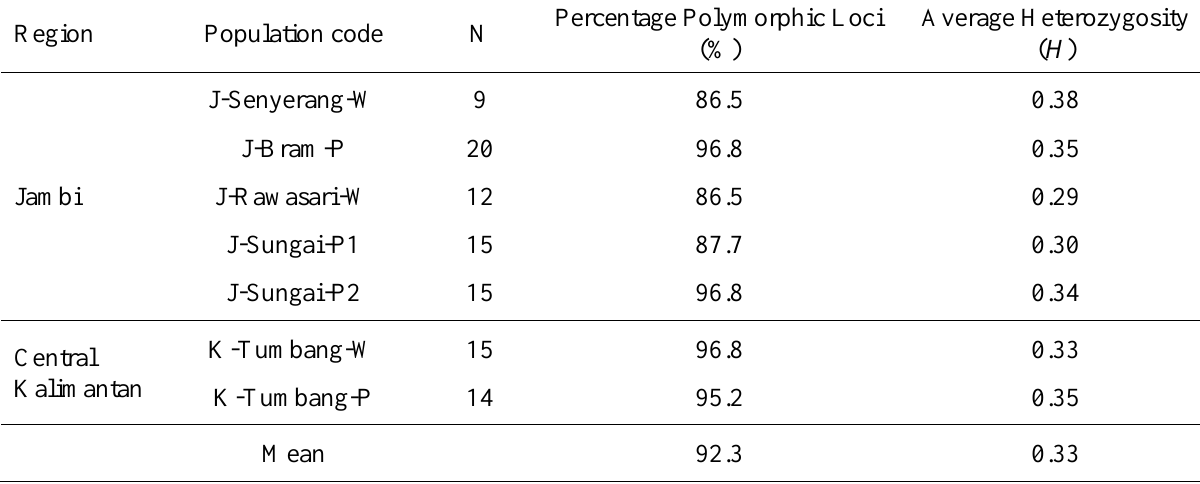
Table 2. Mean diversity estimate ( H ) of 7 Dyera polyphylla population generated from 280 AFLP markers. The population codes are explained in Table